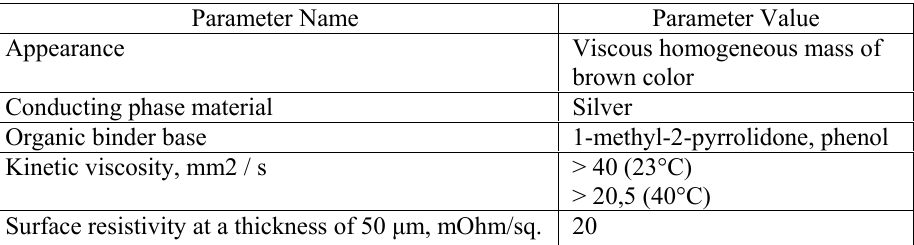
Table 1. Technical specifications of Conductive Ink